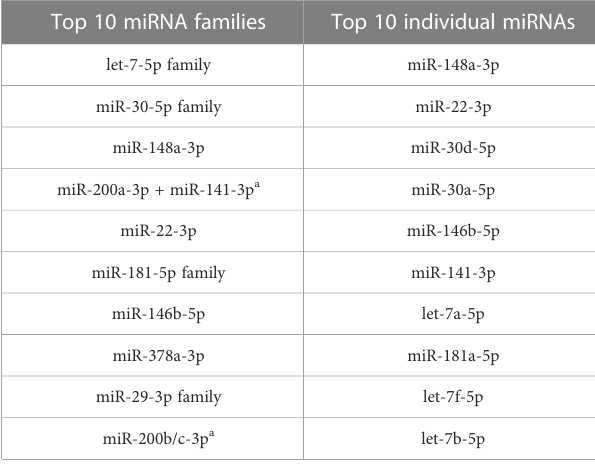
TABLE 1 The top 10 highest ranked human breast milk miRNAs. Top 10 miRNA